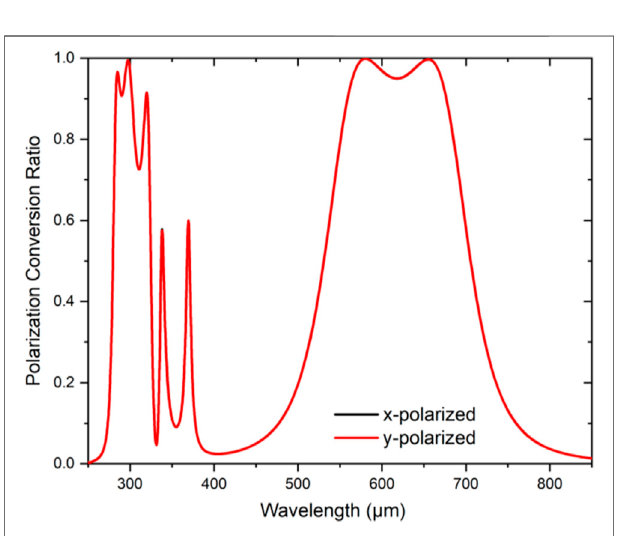
FIGURE 4 | Computed PCR for x- and y-polarized